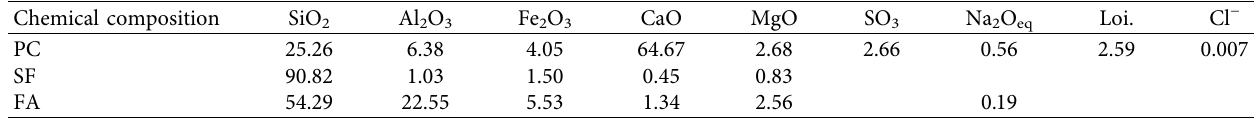
Table 1: Chemical composition of PC, SF, and